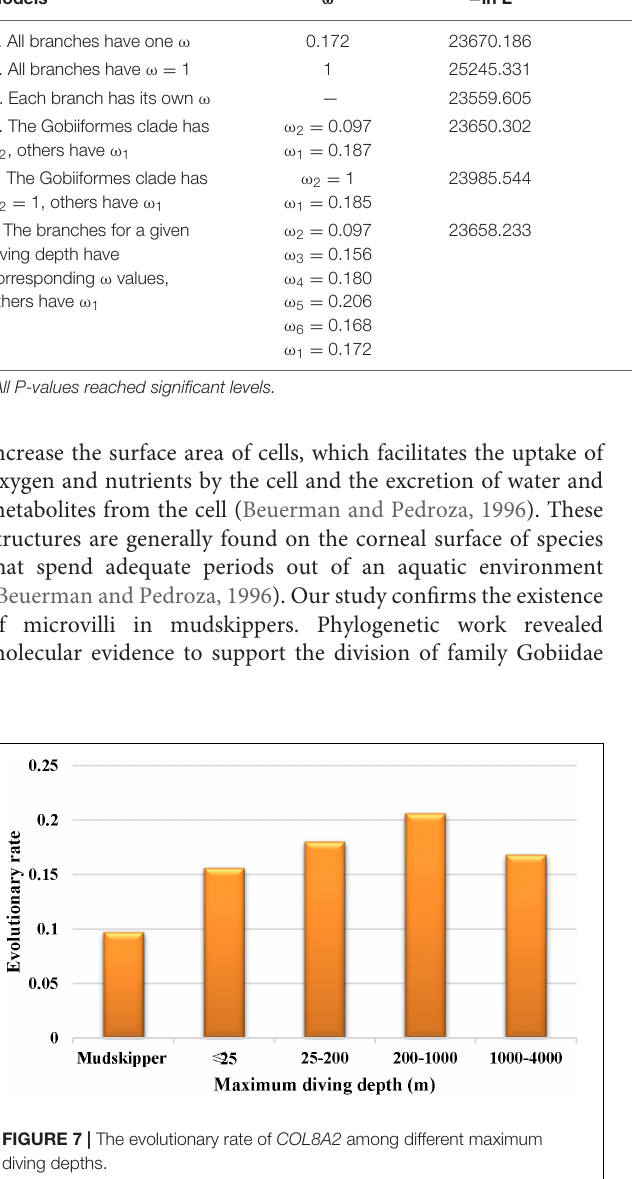
TABLE 2 | Likelihood and omega values estimated under branch models of selection pressures on the COL8A2 gene. Models